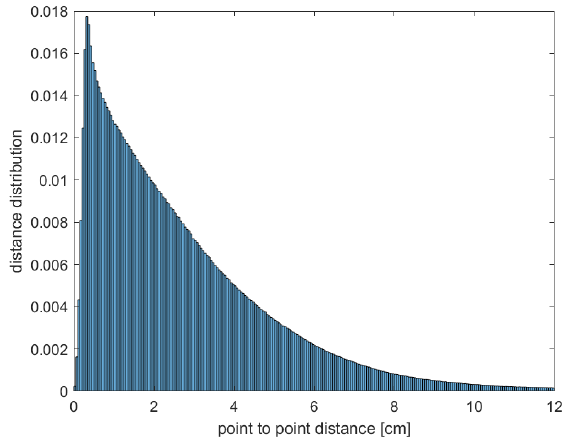
Figure 6. Point-to-point distance between point clouds generated with photogrammetry and ToF camera.